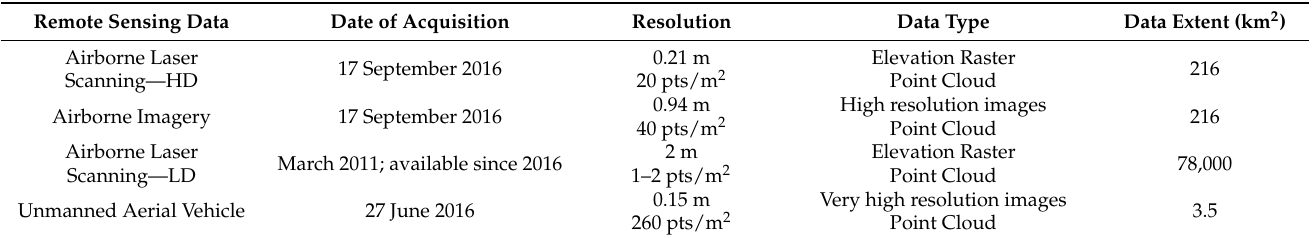
Table 2. Detailed characteristics of the four types of remote sensing-based input data used in the